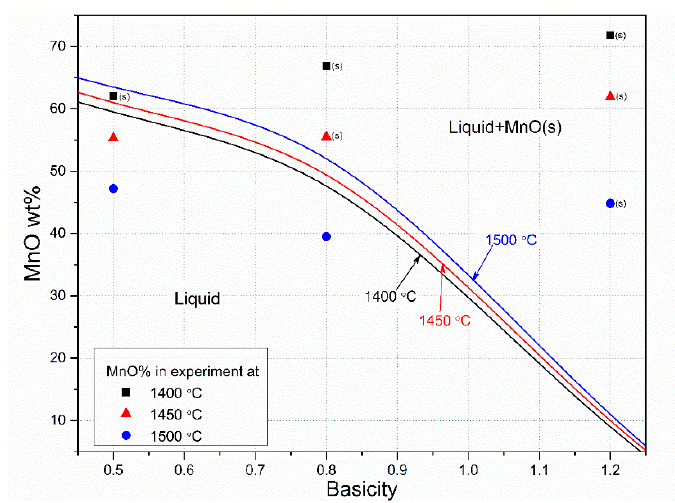
Figure 8. Curves of %MnO of the slag at liquidus temperature, calculated from liquidus relations for the MnO–SiO 2 –CaO system in Figure 7. The dots are experimental points, and the (S) marks where spherical MnO phase is observed.